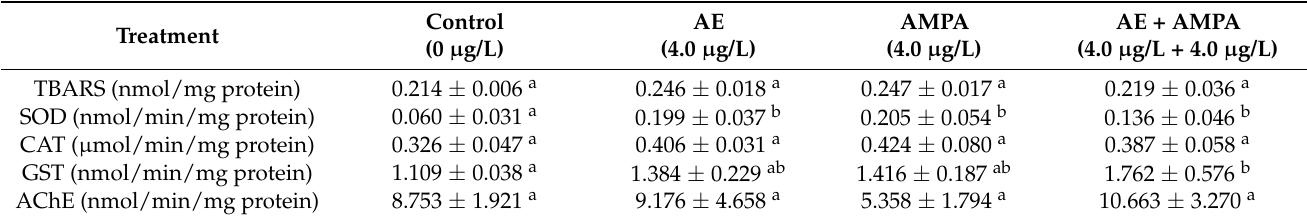
Table 2. Antioxidant and oxidative biomarkers in whole-body homogenates of marbled crayfish Procambarus virginalis (N = 12) after 50-day exposure to acetochlor ESA (AE), aminomethylphospho- nic acid (AMPA) and their combination (AE + AMPA); different superscripts indicate significant difference among groups ( p < 0.01). Data are means ± S.D.